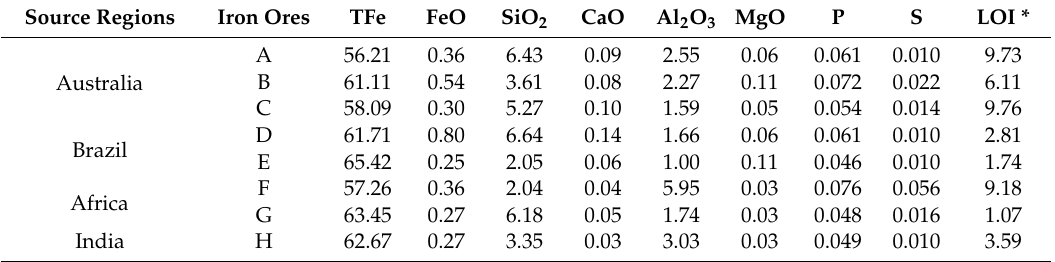
Table 1. Chemical compositions of iron ores (wt%).